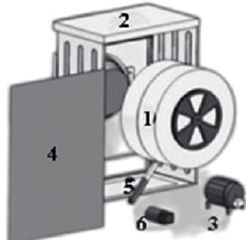
Figure A3. Schematic diagram of a washing machine [35].